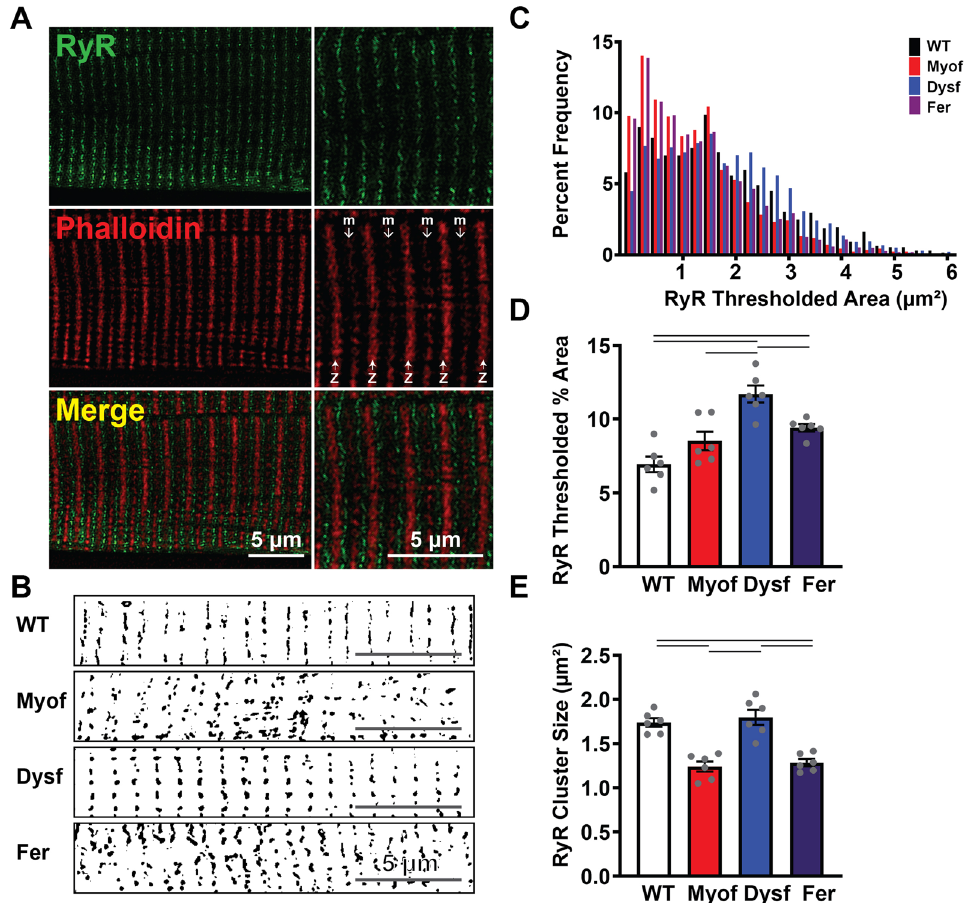
Figure 4. Super-resolution structured illumination microscopy (SIM) reveals abnormal ryanodine receptor cluster organization following loss of myoferlin. ( A ) Representative SIM images of anti-RyR (green) and phalloidin-stained (red) Z-disks (z, open arrow) and M-lines (m, closed arrow) in isolated FDB myofibers. ( B ) Representative Otsu thresholded SIM images show alterations in RyR clusters. ( C ) Smaller RyR cluster sizes occur at higher frequencies in Myof and Fer myofibers, with a tendency for more RyR clusters larger than 40 pixels in size in Dysf myofibers (N = 2 mice, 6 cells per group, Clusters: WT 1286; Myof 2261; Dysf 1983; Fer 2868). ( D ) RyR cluster % area is significantly higher in Dysf myofibers (N = 2 mice, 6 cells per group). ( E ) Analysis of average RyR cluster sizes following Otsu thresholding shows significantly smaller clusters in Myof and Fer fibers. (N = 2 mice, 6 cells per group). Bar = p < 0.05 by One-Way